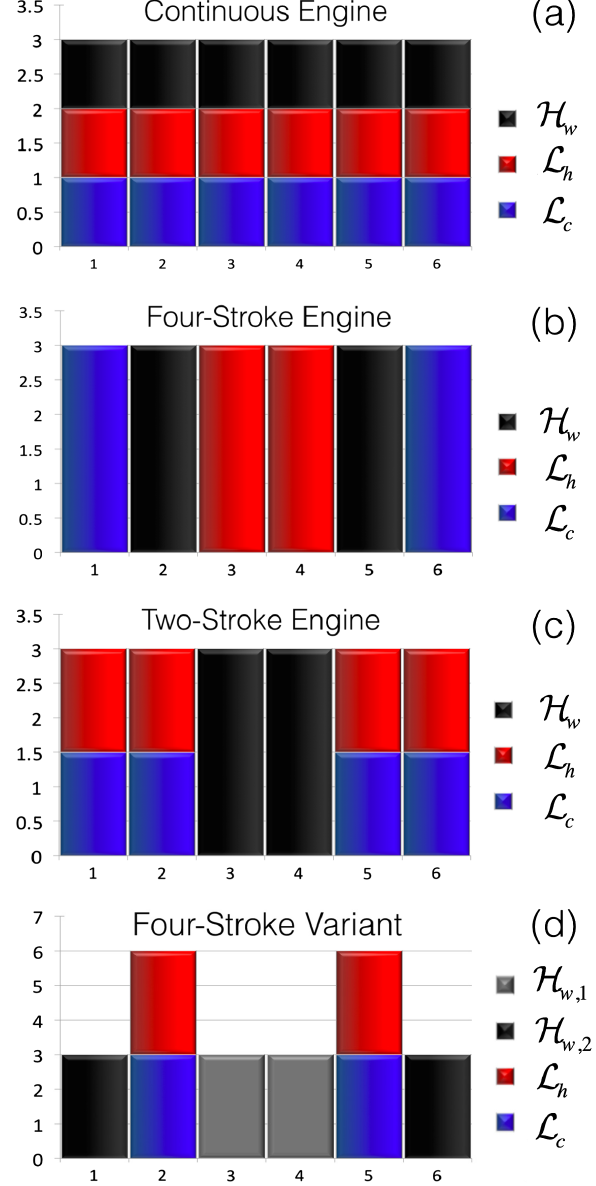
FIG. 5. Graphical illustrations of the super-Hamiltonians of various engines (a) – (d). The horizontal axis corresponds to time. The brick size corresponds to the strength of the coupling to the work repository or to the baths. The Hamiltonians are related to each other by applying the Strang decomposition to the evolution operators (12), (13), and (20). The symmetric rearrangement theorem ensures that in the limit of small action, any rearrange- ment that is symmetric with respect to the center and conserves the area of each color does not change the total power and heat over one